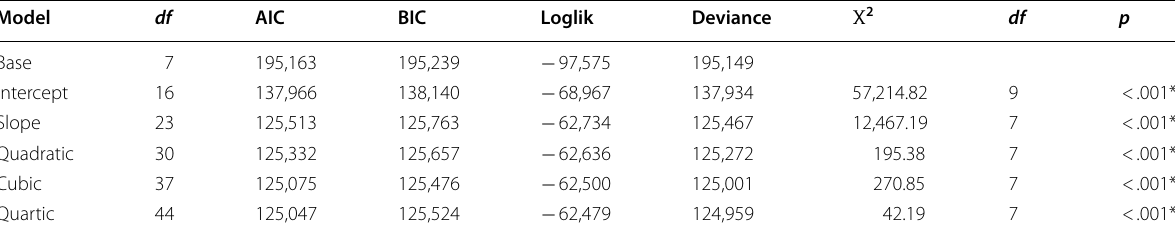
Table 4 Maximum likelihood model comparison in E2